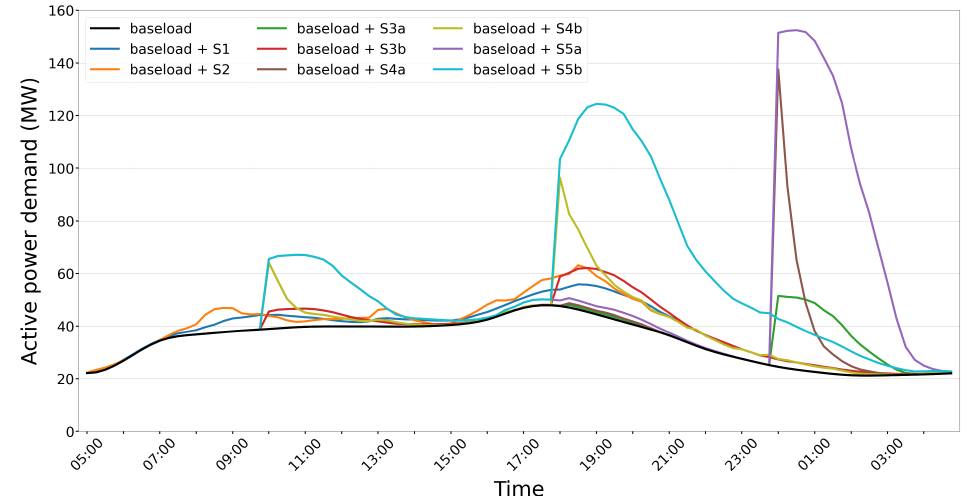
Figure 7. Aggregated active power demand of all three power distribution networks in Frederiksberg, illustrated from 05:00 on 6 January 2020 to 04:45 on 7 January 2020. While the black plot indicates the aggregated baseload, the aggregated demand (comprising both baseload and EV load) is illustrated by different colors for each charging scenario.